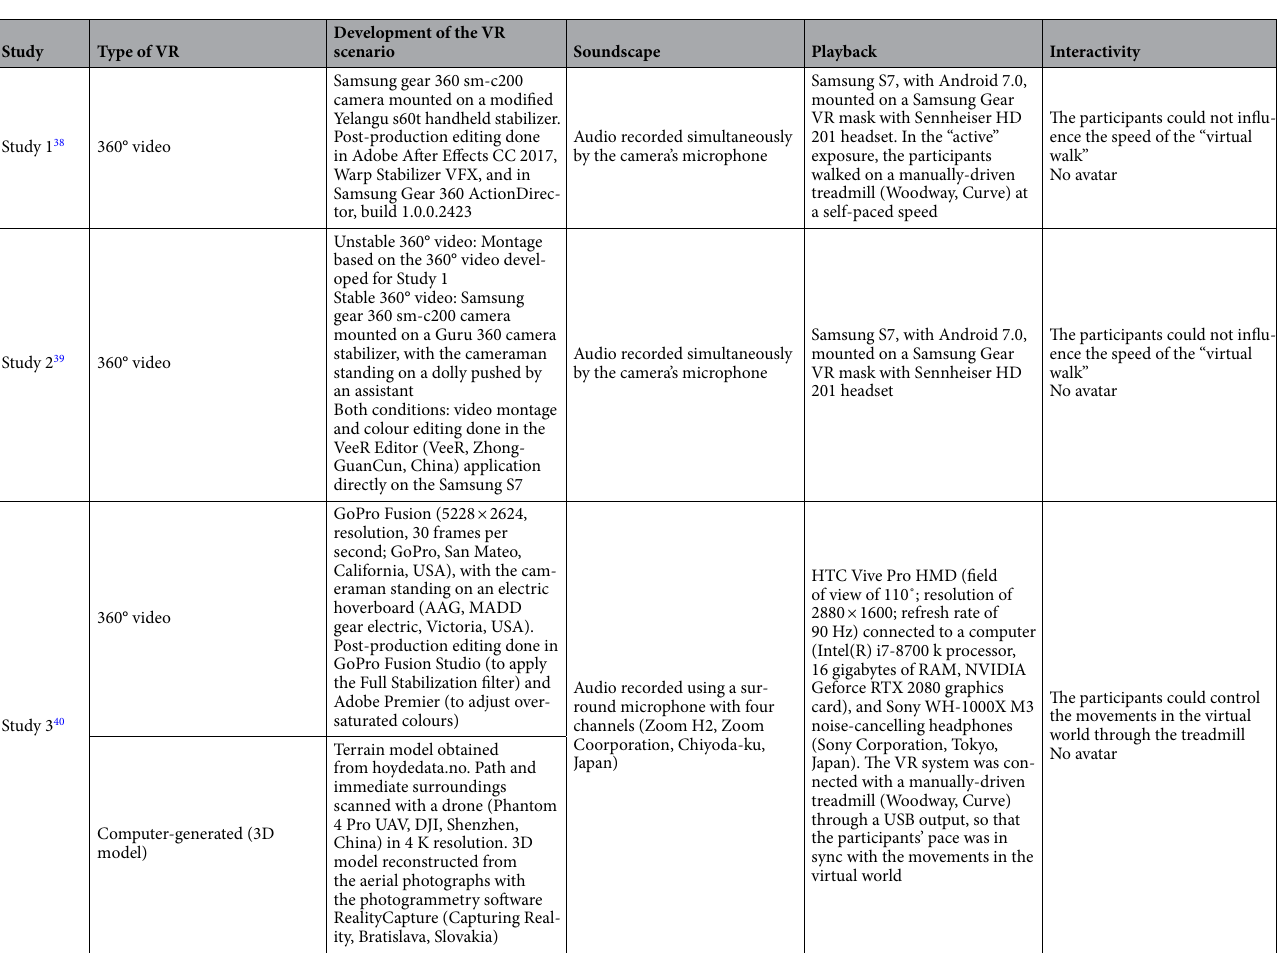
Table 2. Overview of technology and techniques employed to develop and deliver the VR scenarios in the different studies. Demo videos of all VR scenarios are available online at https:// www. youtu be. com/ chann el/ UCbzH 1x-- keKGw lnpwN RWUxA/